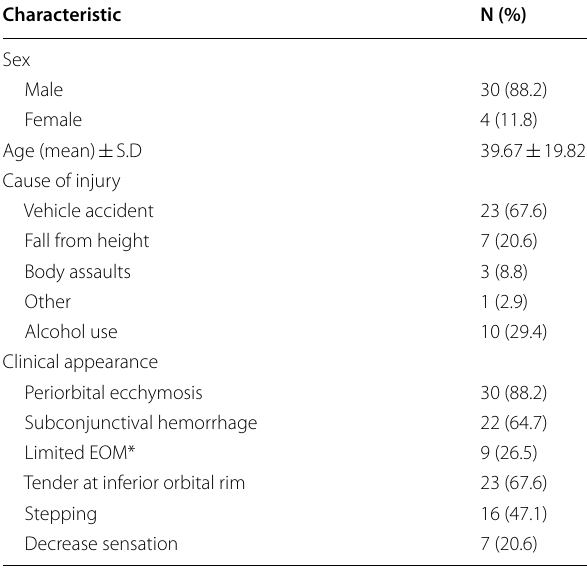
Table 1 Baseline clinical characteristic of 34 patients